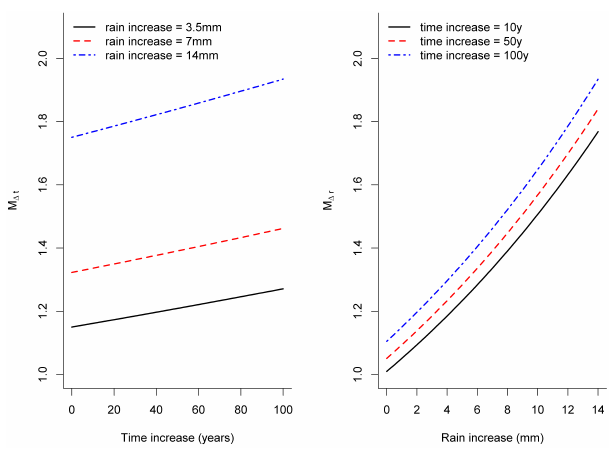
Fig. 7. Illustrative examples of magnification factors for river flows for different values of 1t and 1r , taking β 1 = 0 . 001 and β 2 = 0 .